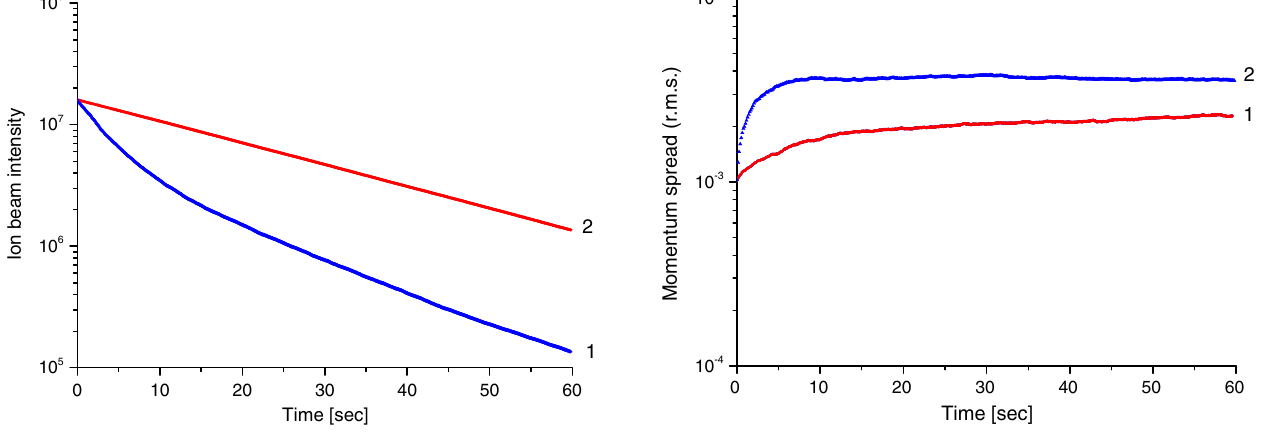
FIG. 7. Evolution of rms momentum spread of a 22 keV O (cid:3) beam. While 10 6 ions are injected in the ring (red curve 1), equilibrium is dp=p (cid:9) 2 : 2 (cid:6) 10 (cid:3) 3 (rms). When 1 : 6 (cid:6) 10 7 ions are injected in the ring (blue curve 2), the growth rates are higher and equilibrium momentum spread is dp=p (cid:9) 4 (cid:6) 10 (cid:3) 3